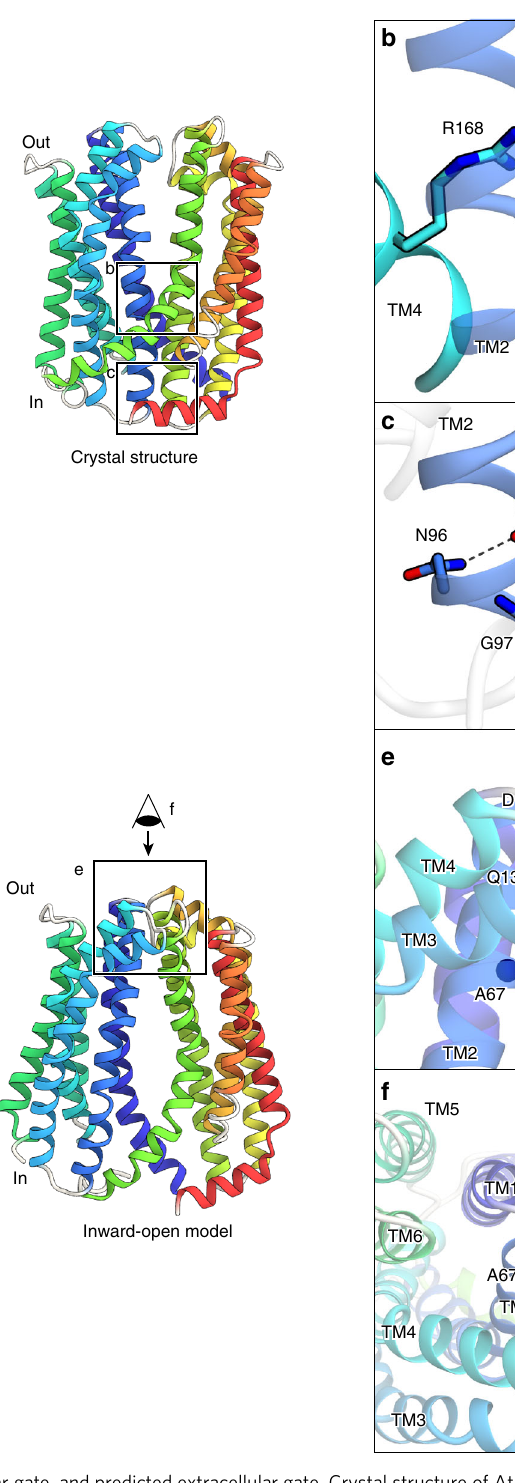
Fig. 3 Internal cavity, intracellular gate, and predicted extracellular gate. Crystal structure of AtDTX14 ( a – c ) and the modeled structure of the inward-open state ( d – f ), viewed parallel to the membrane. The model structure was created by, respectively, superimposing the N-lobe and C-lobe of AtDTX14 onto the N-lobe and C-lobe of the crystal structure of MurJ (PDB ID: 5T77), using the SSM superpose algorithm 41 . The resulting RMSD values are 2.90 Å and 2.06 Å for the N-lobe and C-lobe, respectively, indicating their structural similarities despite the low-sequence identity (~4%). b Close-up view of the bottom of the internal cavity. The bottom is closed by the salt-bridge network, which is represented by dashed lines. c Close-up view of the intracellular gate. The intracellular Gly pair (G97 and G319) enables the side-by-side interaction between TM2 and TM8. e , f Close-up views of the putative extracellular gate, viewed parallel to the membrane ( e ) and perpendicular to the membrane ( f ). The blue spheres and lines indicate the residue pairs with high EC scores, calculated by the program EVfold_membrane